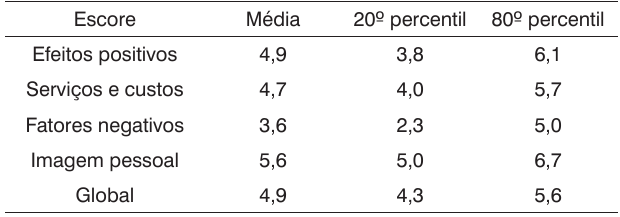
Quadro 1. Valores da média, do 20º e do 80º percentil para os escores global e de cada subescala do SADL.